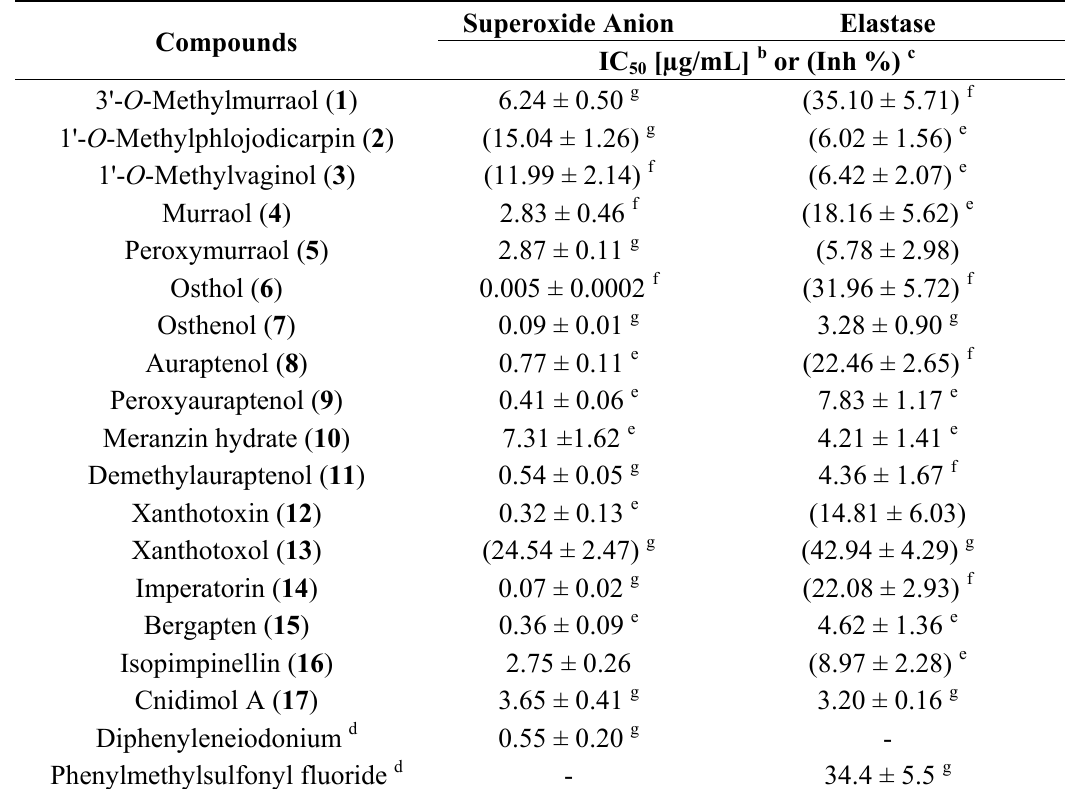
Table 1. Inhibitory effects of compounds 1 – 17 from the fruits of C. monnieri on superoxide radical anion generation and elastase release by human neutrophils in response to fMet-Leu-Phe/cytochalasin B a